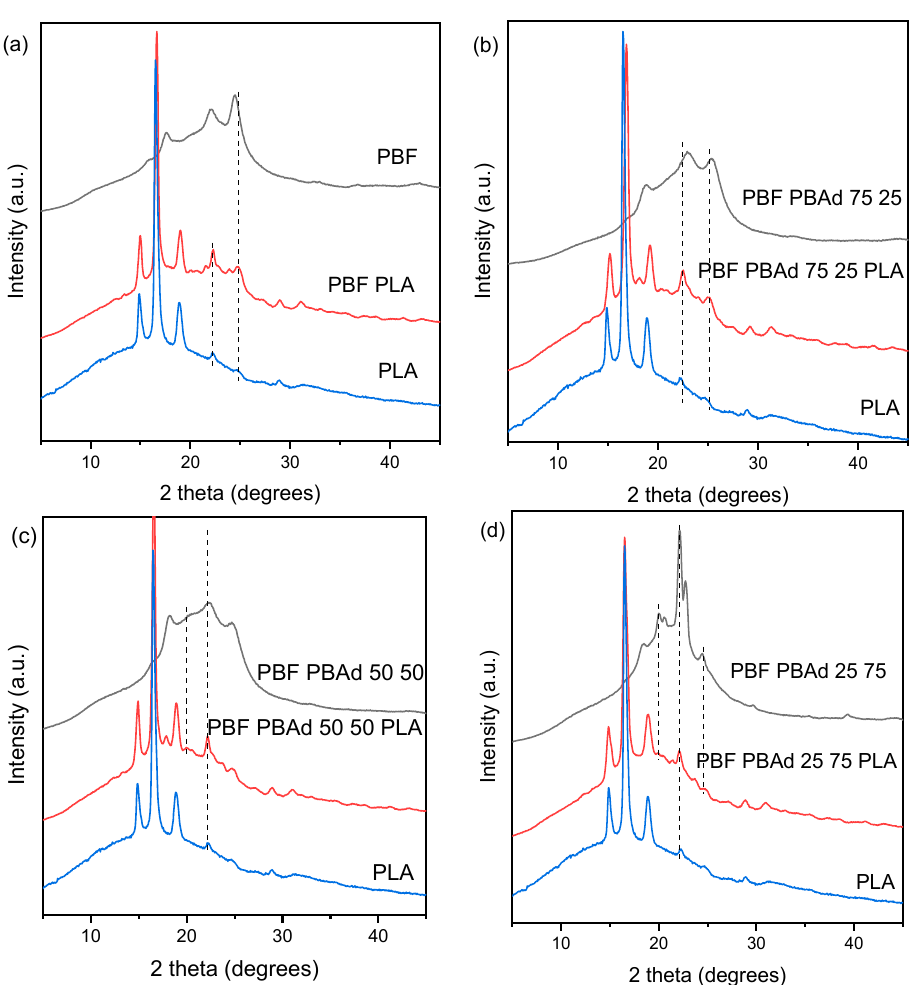
Figure 5. XRD patterns of isothermally cold-crystallized ( a ) PLA, PBF and PBF PLA blend ( b ) PLA, PBF-PBAd 75 25 and PBF-PBAd 75 25 PLA blend, ( c ) PLA, PBF-PBAd 50 50 and PBF-PBAd 50 50 PLA blend and ( d ) PLA, PBF-PBAd 25 75 and PBF-PBAd 25 75 PLA blend.